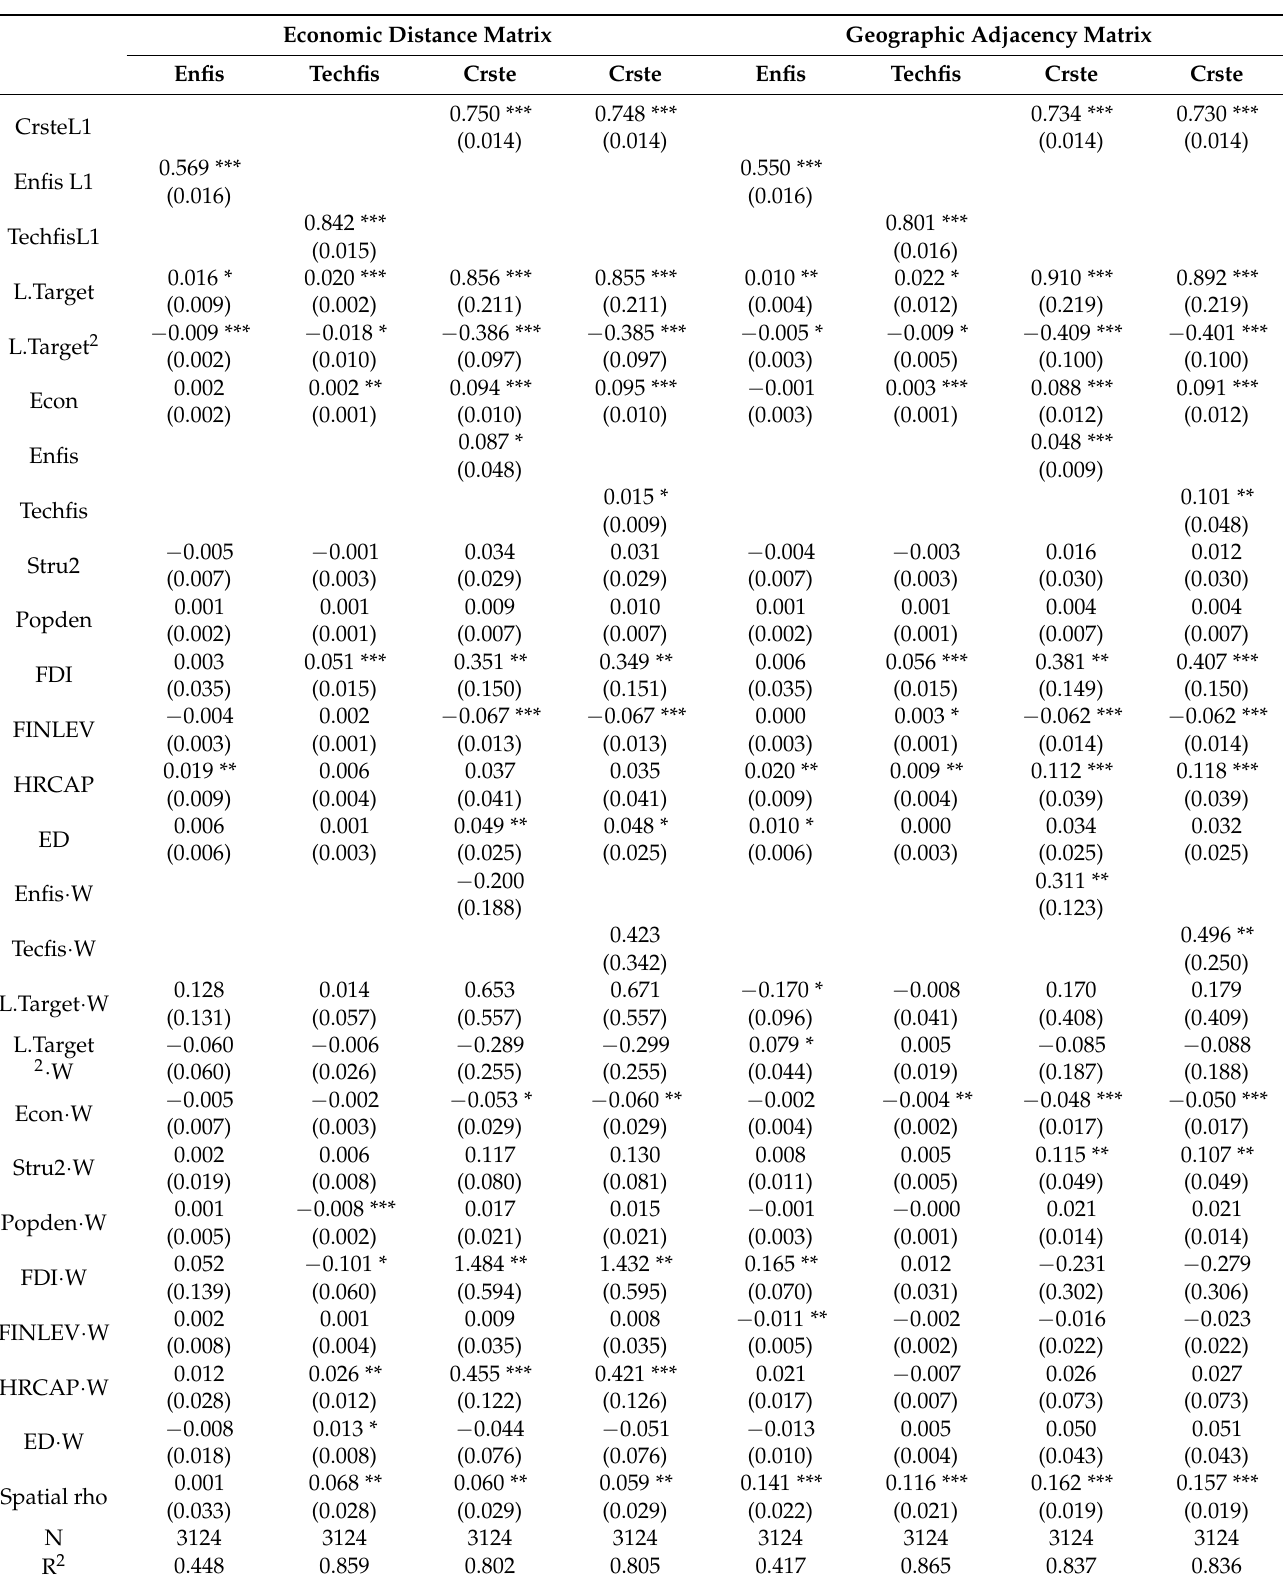
Table 8. Mechanism